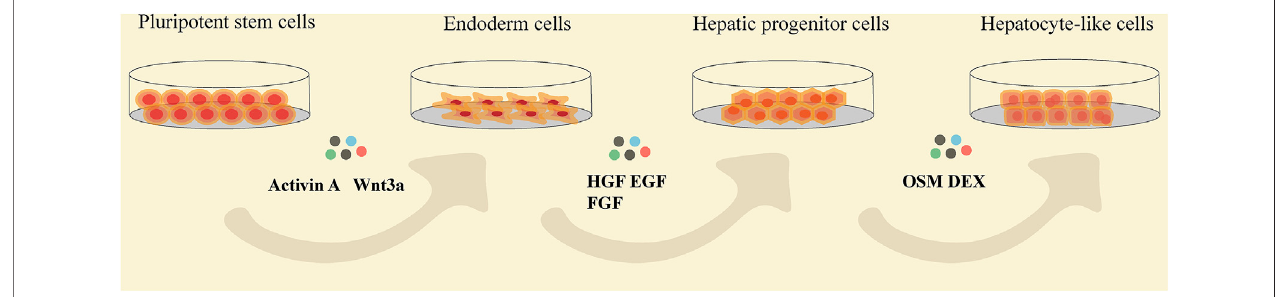
FIGURE 3 | The fl ow chat showing the stages of pluripotent stem cells differentiating into HLCs and the common cytokines added at each differentiation stage. HGF, hepatocyte growth factor; EGF, epidermal growth factor; FGF, fi broblast growth factor; OSM, oncostatin M; DEX, dexamethasone.